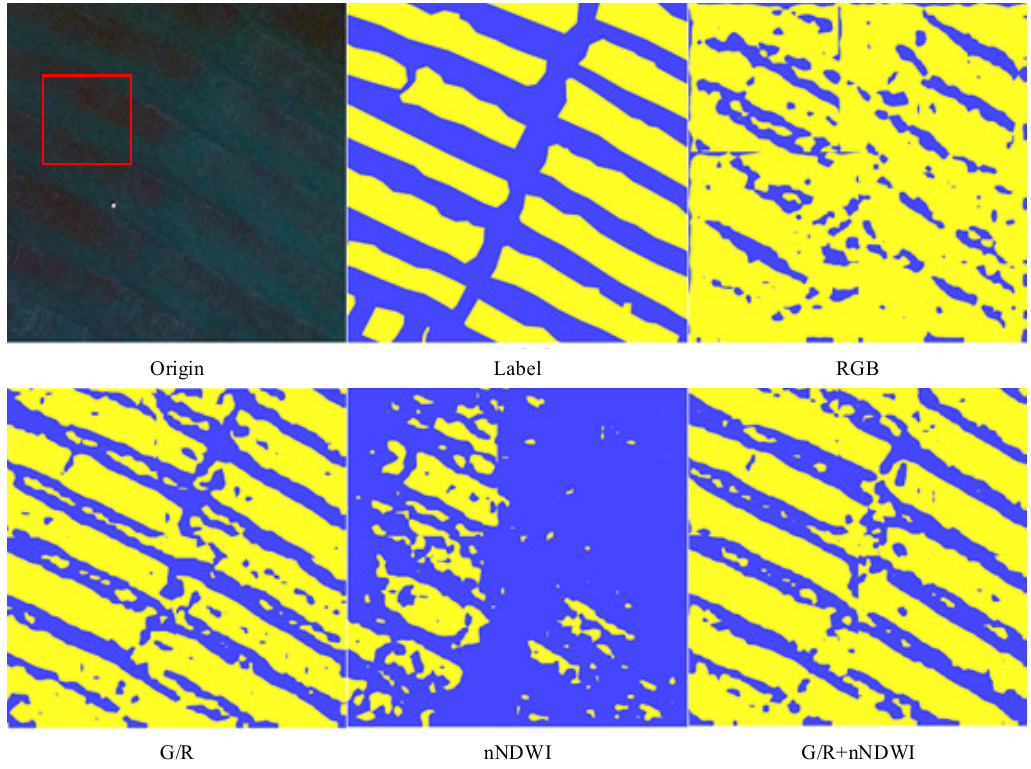
Figure 7. Classification results of di ff erent groups under extremely weak signal.